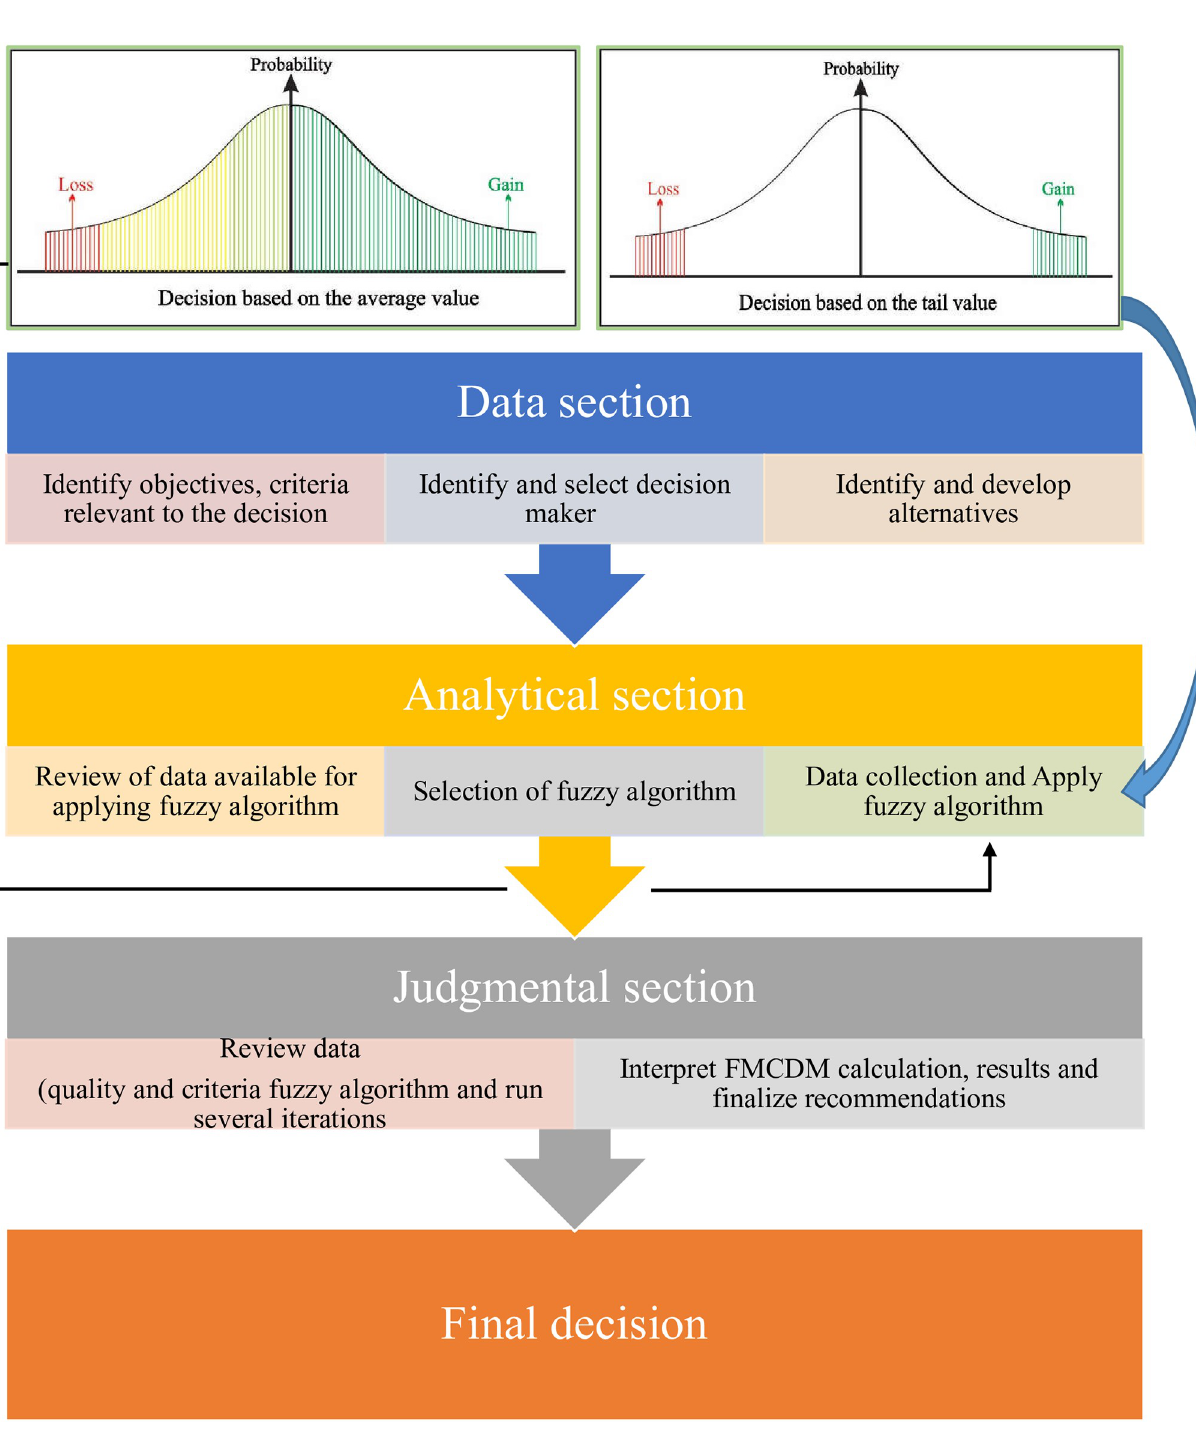
Fig 1. Comparison of TDM and MCDM.